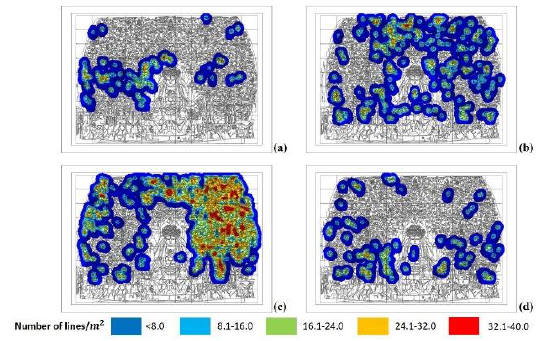
Figure 7 . The outcomes of kernel density analysis which can be related to condensate water